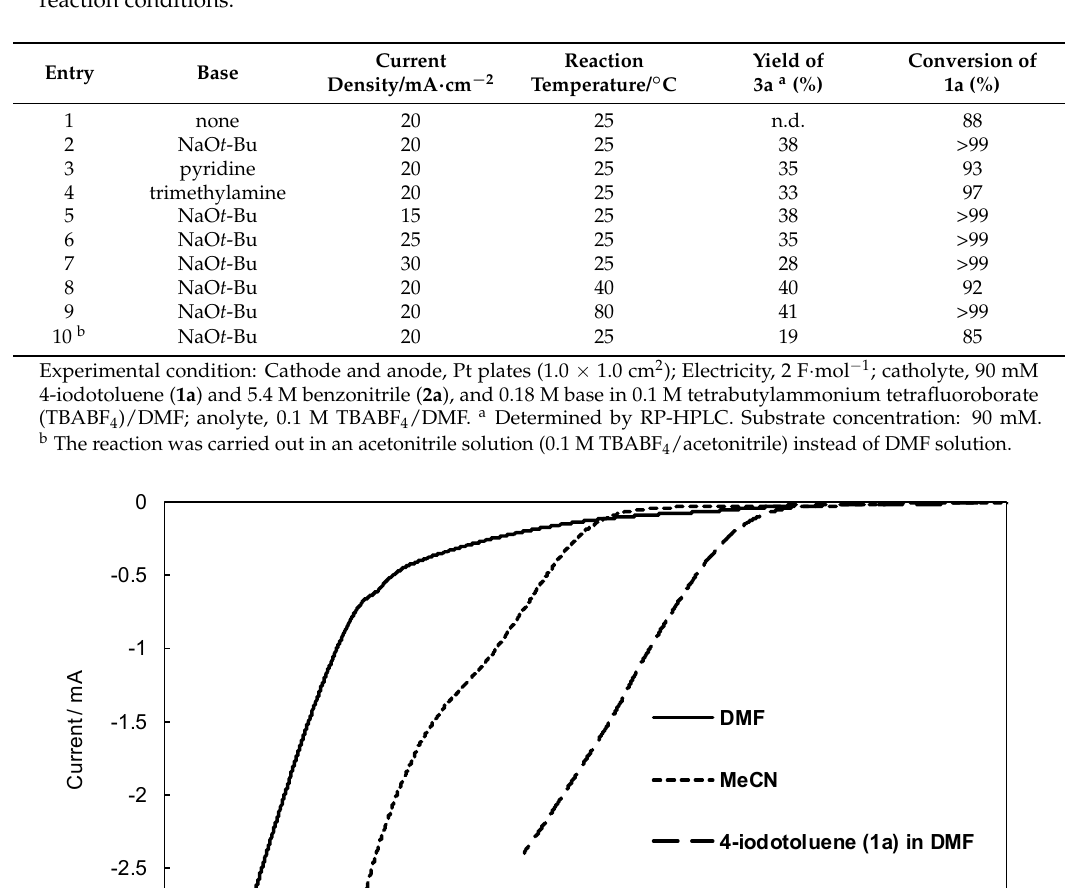
Table 2. Cathodic cross-coupling reaction of 4-iodotoluene ( 1a ) with benzonitrile ( 2a ) in various reaction conditions.